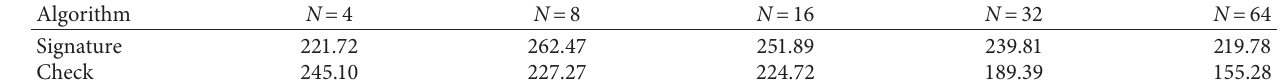
Table 4: Algorithm performance at different matrix